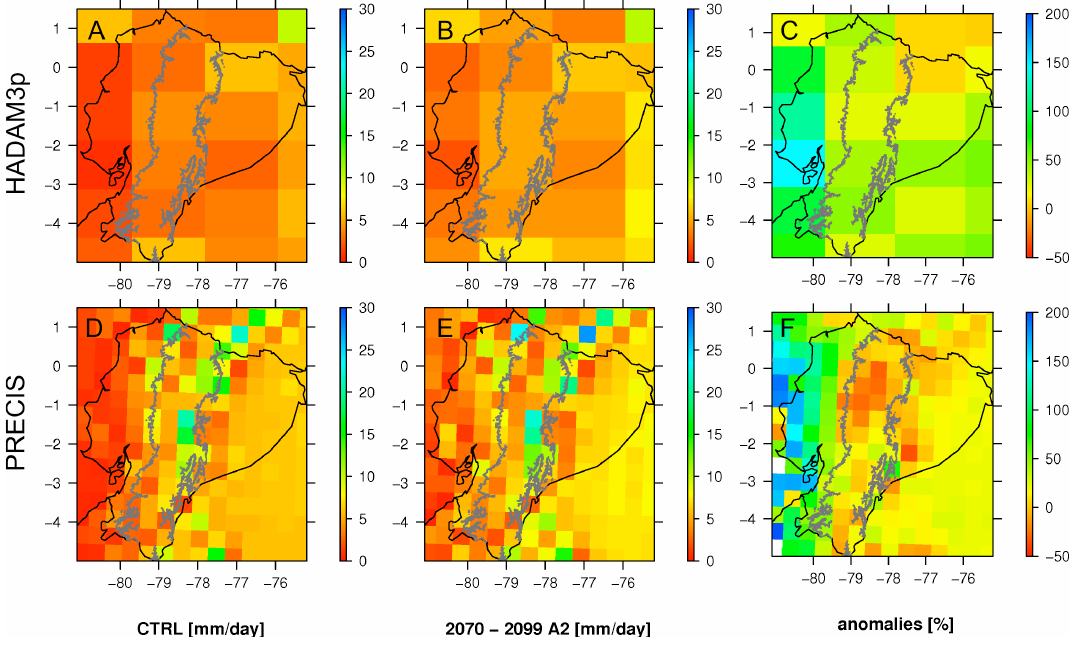
Fig. 4. A and B : Modelled average annual precipitation for the control run and future A2 scenario of HadAM3p (mm/day). C : Relative anomalies in precipitation between the 1961–1990 control run and the 2070–2099 A2 scenario for HadAM3p (%). D – F : idem for PRECIS. The 1000m contour line of the Ecuadorian Andes is indicated in